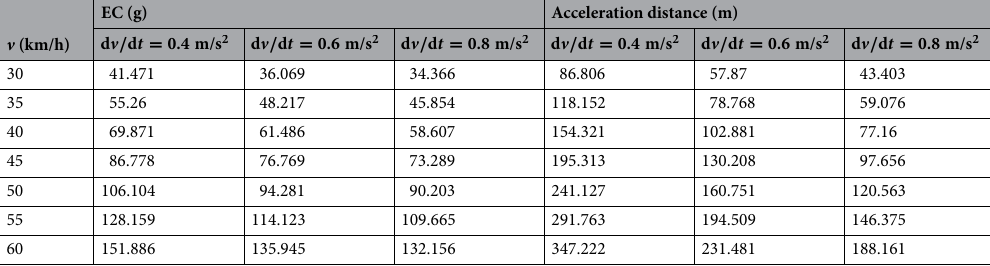
Table 4. Analysis of EC in acceleration phase.